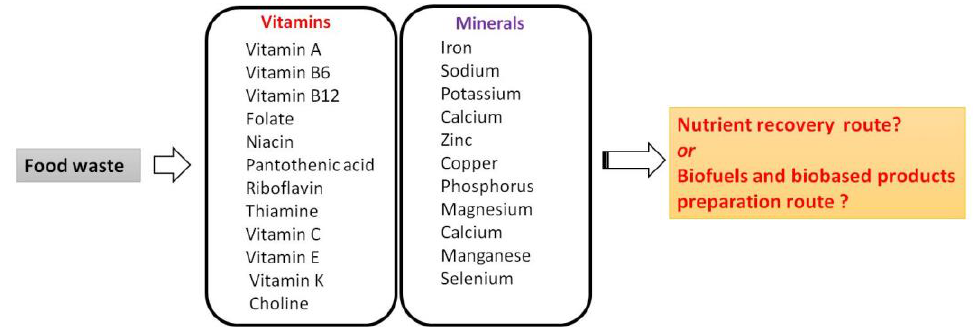
Figure 21. Production of solvents, polymers, biocomposites and hydroxy fatty acids from food waste.